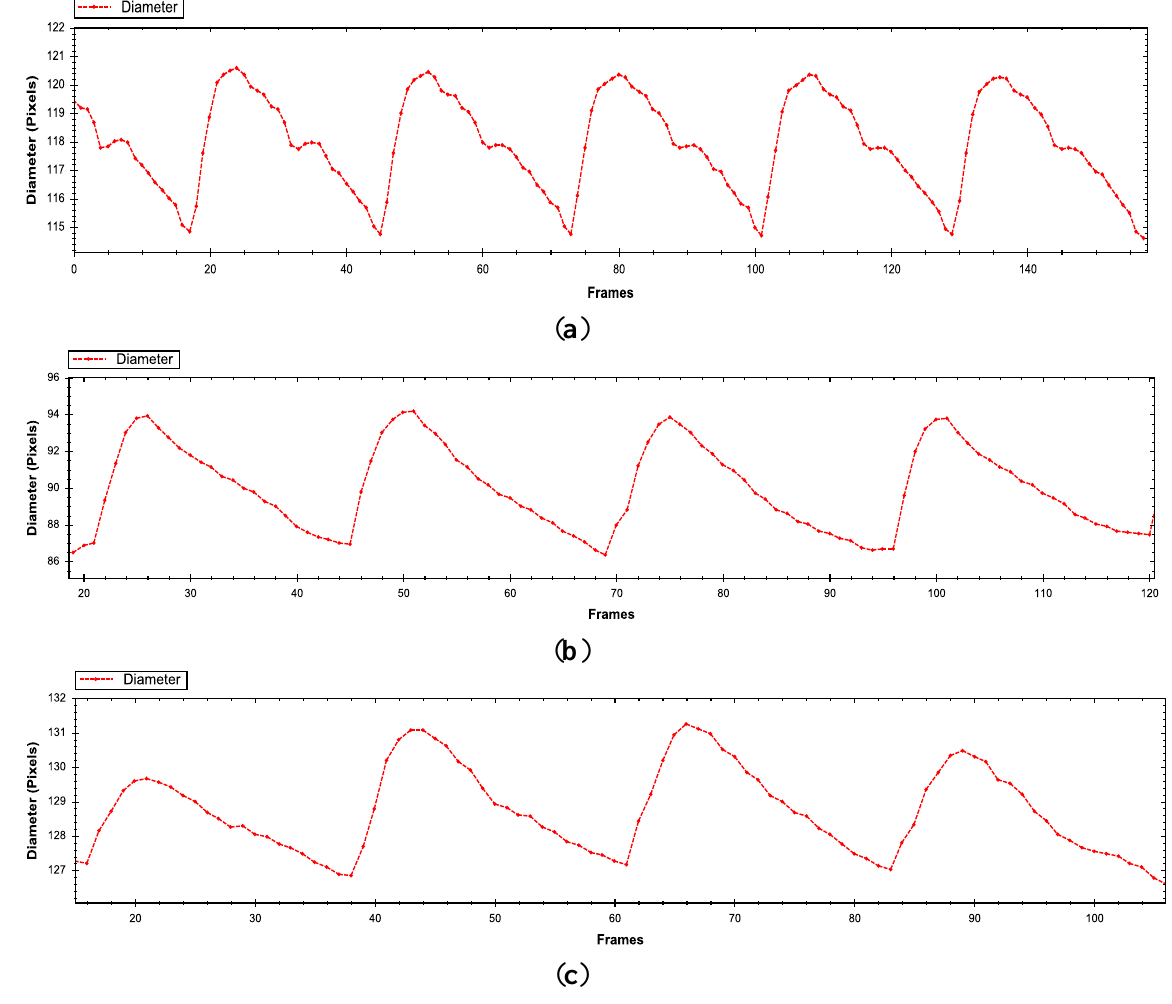
Figure 13. Diameter evolution of the common carotid artery (CCA) in real ultrasound data in different subjects where first row ( a ) correspond to a healthy patient and the last two rows ( b – c ) belong to patients with presence of atheroma